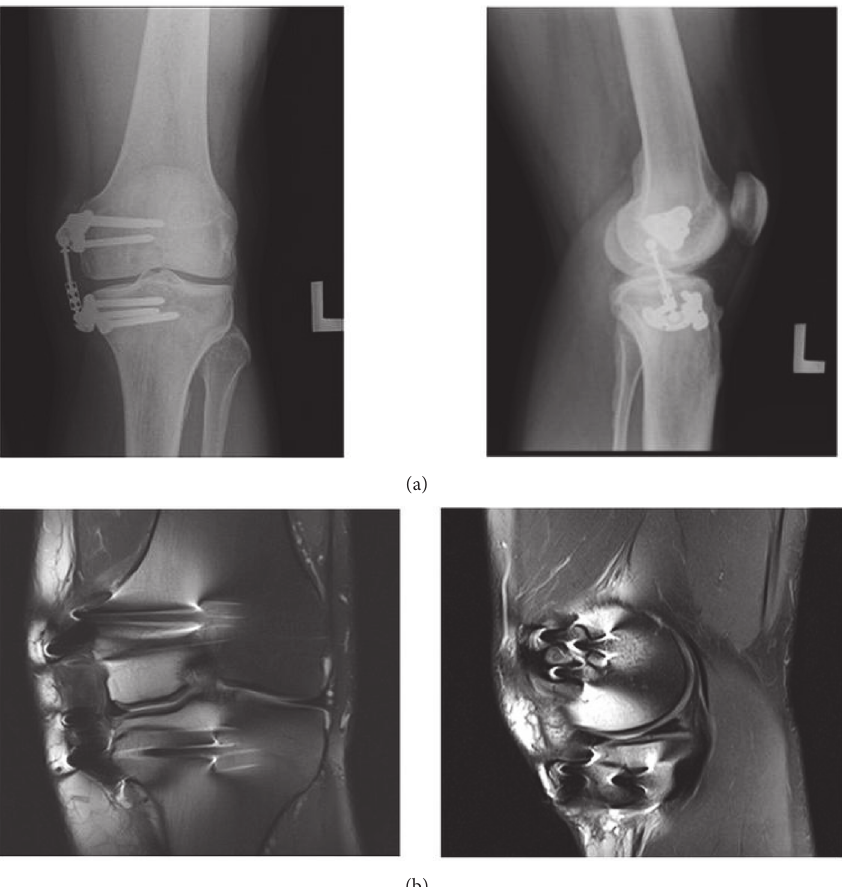
Figure 3: Six-month postsurgery anterior and medial radiographs (a) and coronal and sagittal MRIs (b) of the affected left